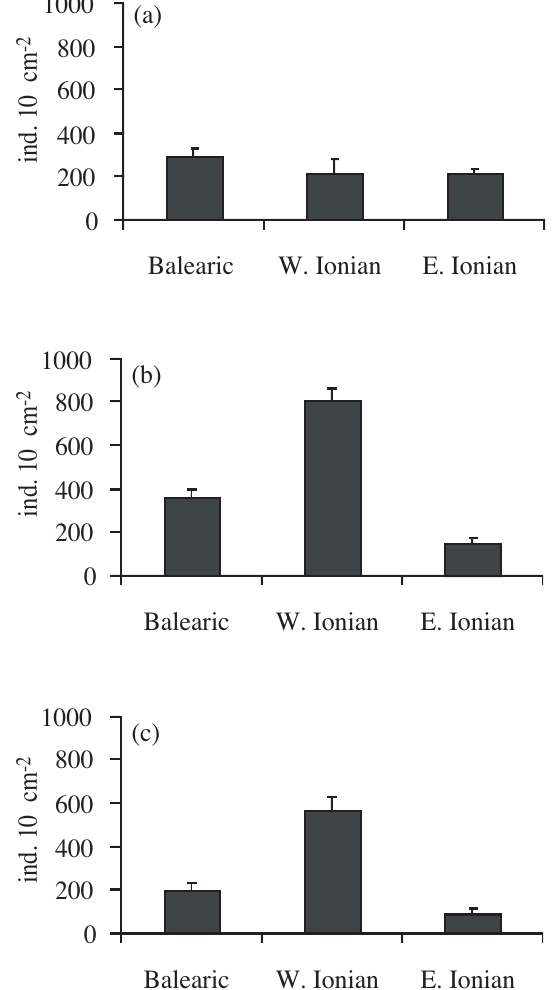
F IG . 3. – Total meiobenthic abundance in the upper 5 cm of the sedi- ment. (a), Stations of 600 m depth (St. 1, 7, 15); (b), Stations of 800 m depth (St. 2, 8, 16); (c), Stations of 1500-1700 m depth (St. 4, 10, MEDITERRANEAN BATHYAL MEIOBENTHOS 43